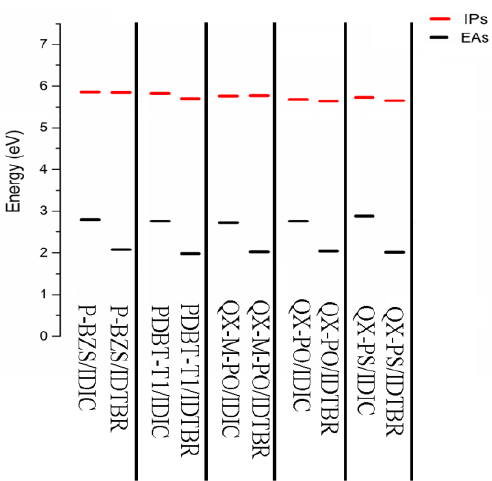
Figure 10. The IPs (EAs) of five polymer/IDIC interfaces and five polymer/IDTBR interfaces, where black line represents EA and red line represents IP.